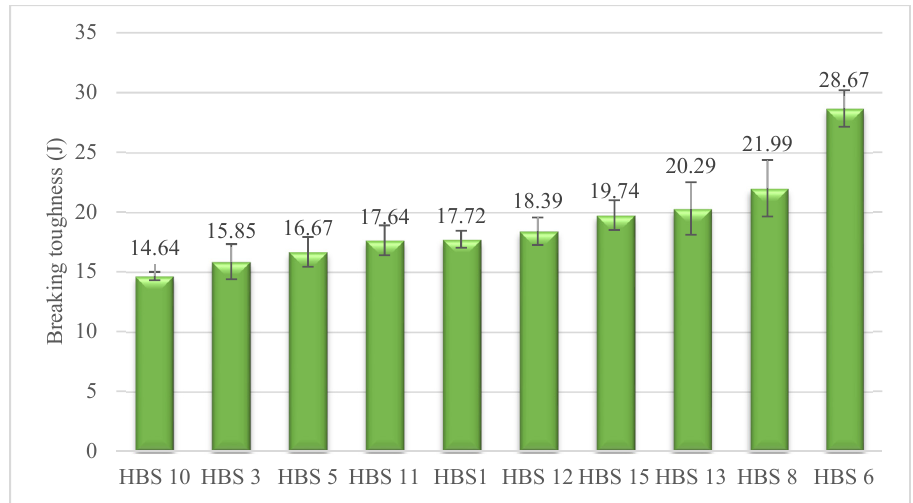
Figure 8. Average breaking toughness of HBSs.